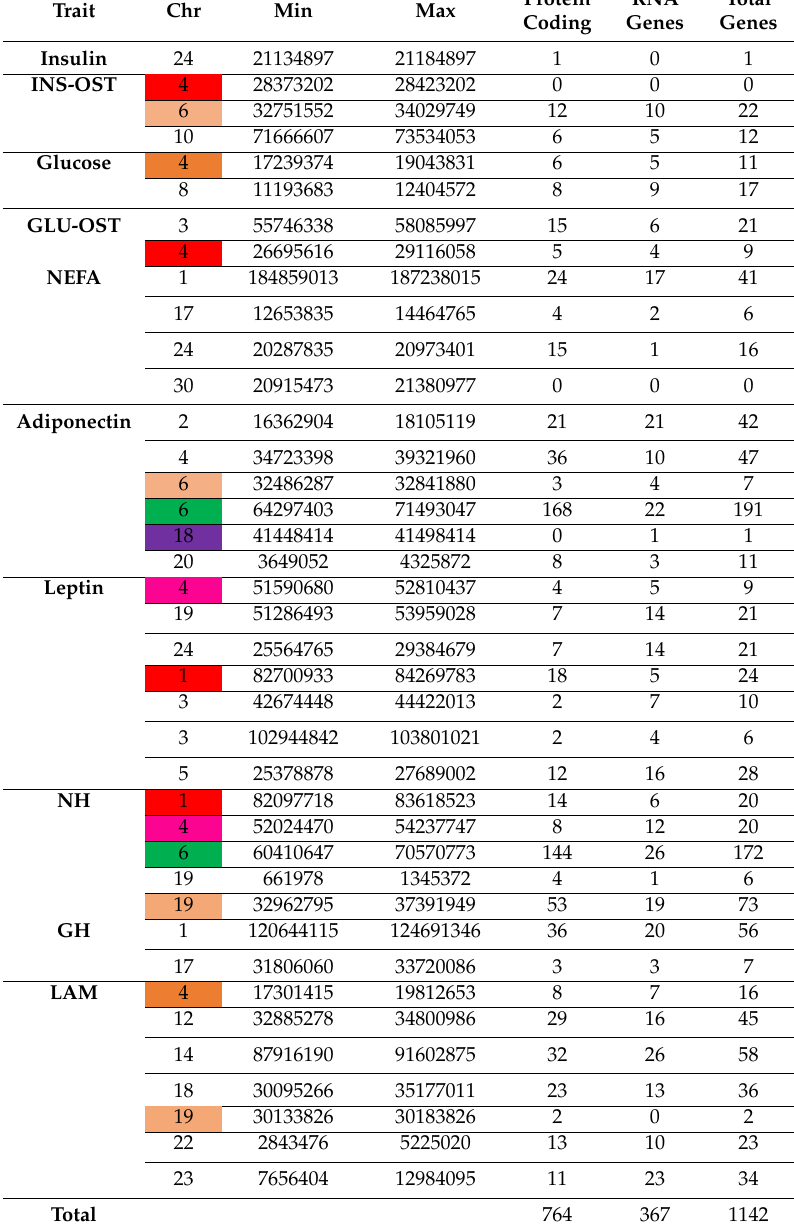
Table 3. LD-bound high priority GWA regions for the Morgan